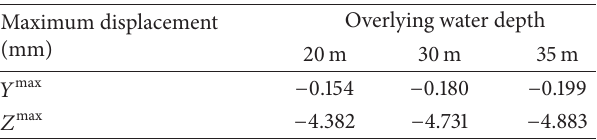
Table 3: Maximum displacements of tunnel structure under differ- ent water